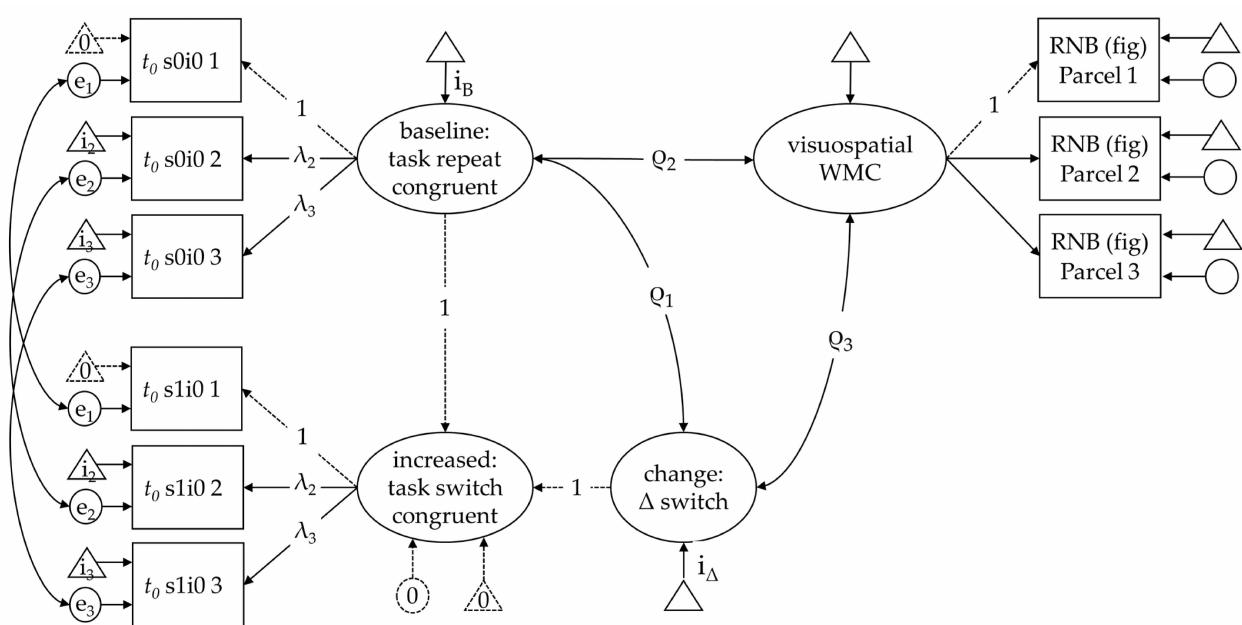
Figure 4. Specification of the latent difference score (LDS) model, as exemplified for the task-switch effect in the diffusion model (DM) non-decision time parameter ( t 0 ), and its relations with visuospatial working memory capacity (WMC) that was assessed using three parallel parcels of the figural Recall- N-Back (RNB) task. Analogous models were estimated for the other parameters. Indicators of the LDS models are systematically named taking into consideration their task switch (s1; s0) and response incongruency (i1; i0) requirements (see Figure 1 for details). Parameters numerically fixed at either 1 or 0 zero are displayed using dashed lines; parameters constrained to be equal are named identically in this figure. The latent correlations between factors ( ρ 1 – ρ 3 ) are provided in Table